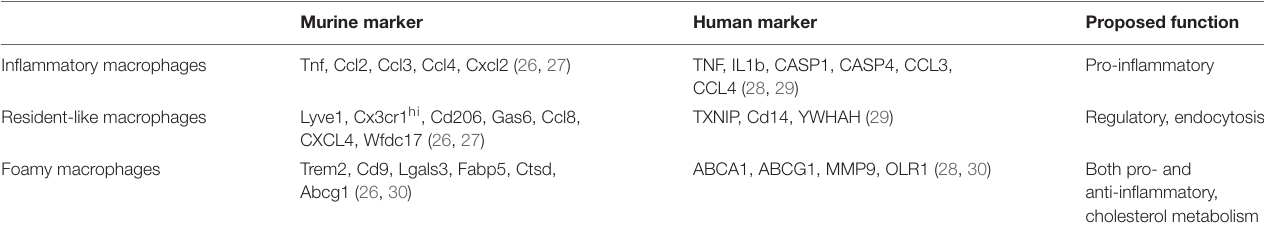
TABLE 1 | scRNA-seq from murine and human arteries identified markers that classify macrophage subsets into inflammatory, resident-like, and foamy macrophages. Murine marker Human marker Proposed